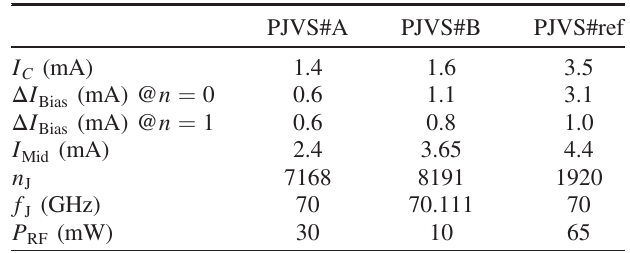
TABLE I. PJVS device